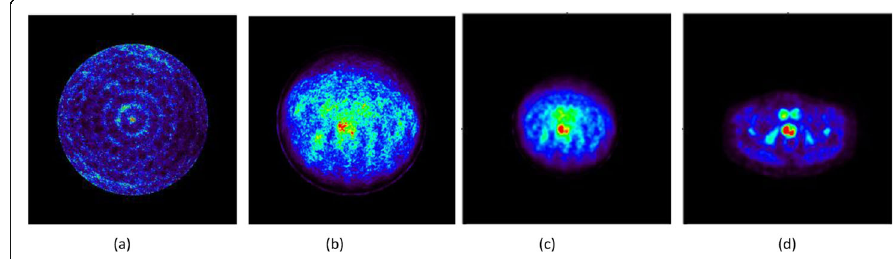
Fig. 15 Image reconstructions using the prostate PET prototype of the patient data before normalization ( a ), with only normalization ( b ), also including CT-based attenuation ( c ). Image of one bed position with the Gemini-TF is depicted in